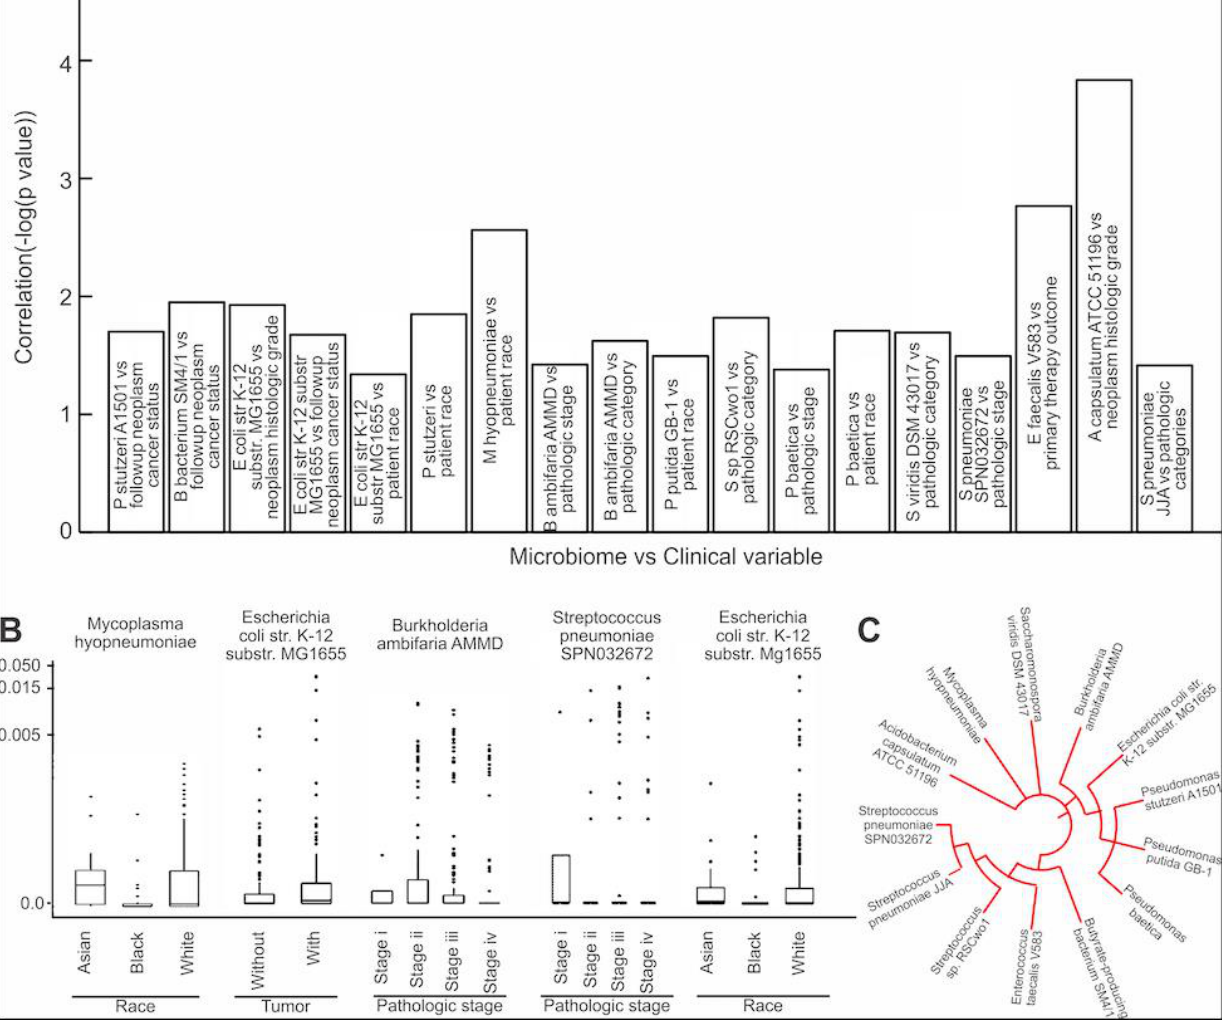
Figure 5. Microbe associations with clinical variables. ( A ) Bar graph of the Kruskal – Wallis correlation p -values. For each significantly correlated Clinical variable/microbe pair, the negative logarithm of the p -value was plotted. ( B ). Boxplots of specific clinical variables vs. microbial abundance (Kruskal – Wallis test, p < 0.05). ( C ) Phylogenic tree for all microbes for which abundance was significantly correlated with clinical variables.